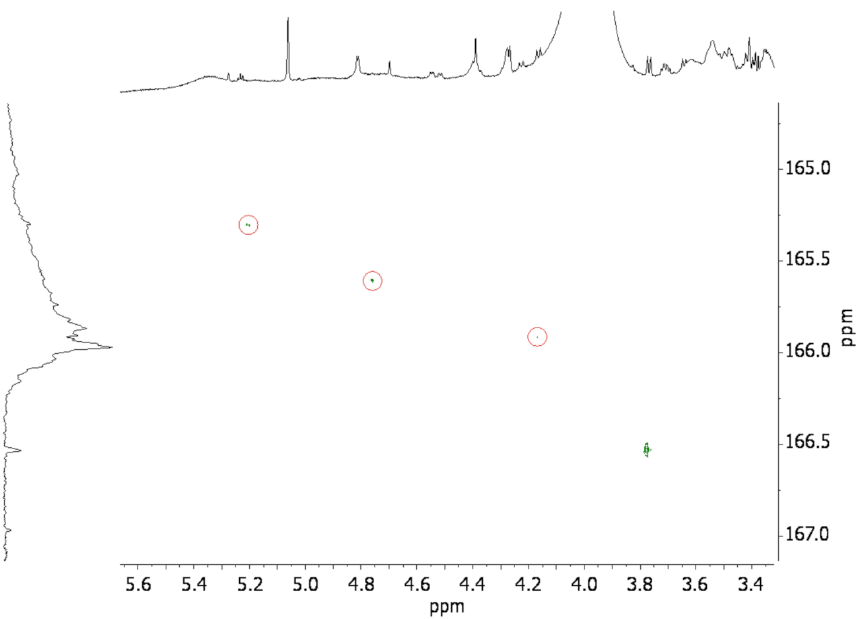
Figure 5. Band-selective 1 H, 13 C-HMBC NMR spectrum of benzoylated wood in DMSO- d 6 /LiCl (non-uniformly recorded with 10% NUS data), weak cross-signals are marked with